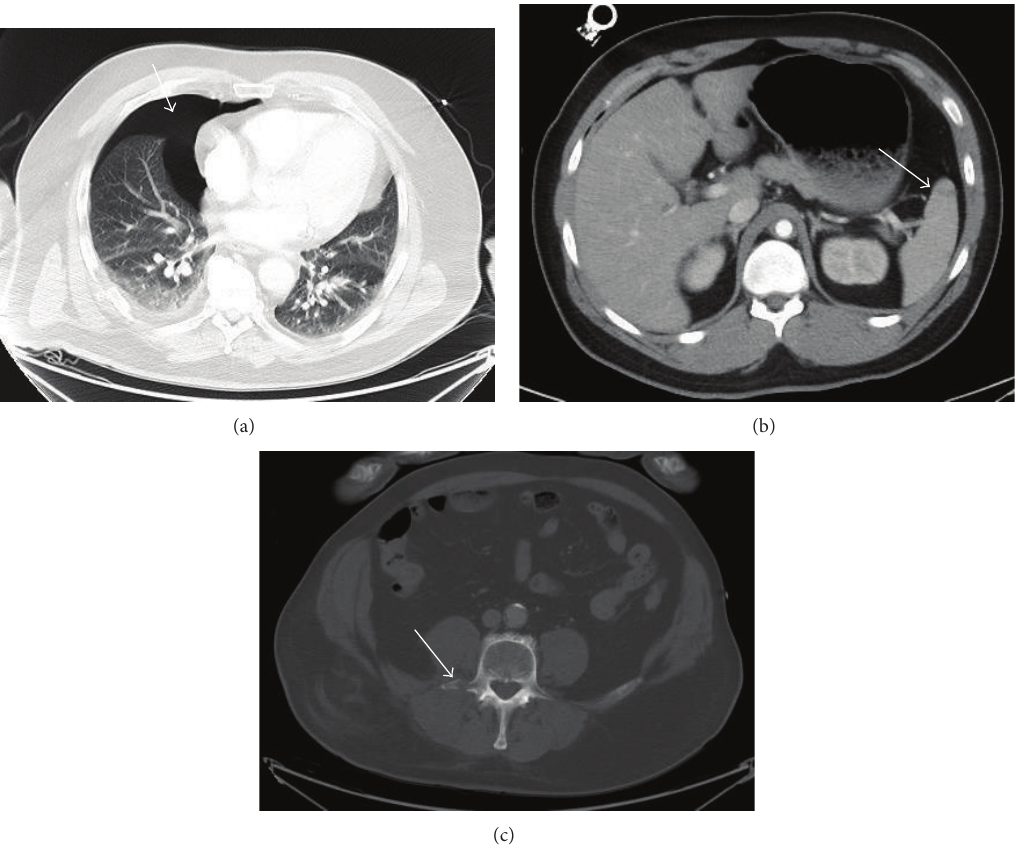
Figure 3: Image acquisition with the IR 30 protocol. In (a) the arrow points to a major ventral pneumothorax of the right lung. In the dorsal area there is pleural effusion with adjacent dystelectasis. In (b) a subtle laceration of the ventral splenic pole is marked by the arrow. Similar to the FBP protocol in Figure 1, a fracture of a transverse process of L4 without major dislocation can be diagnosed on the right